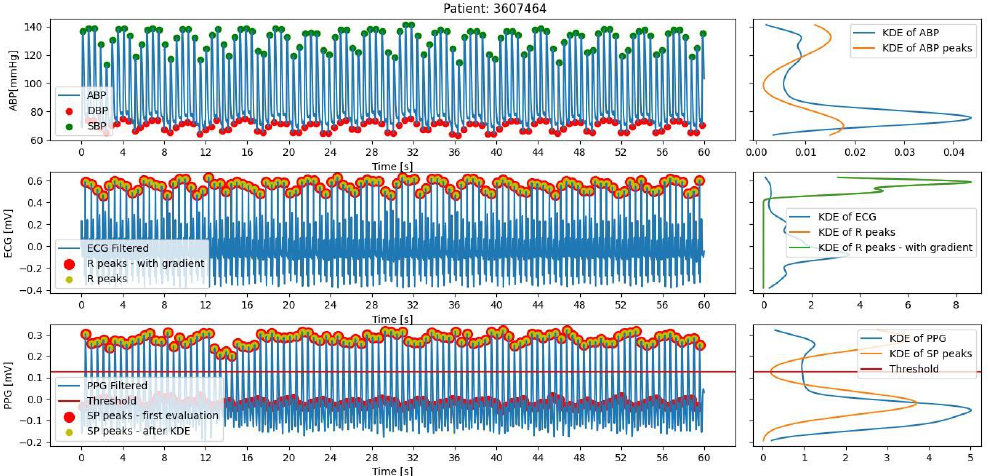
Figure 8. Peak finder and estimated probability density function (KDE) of amplitude of peaks.